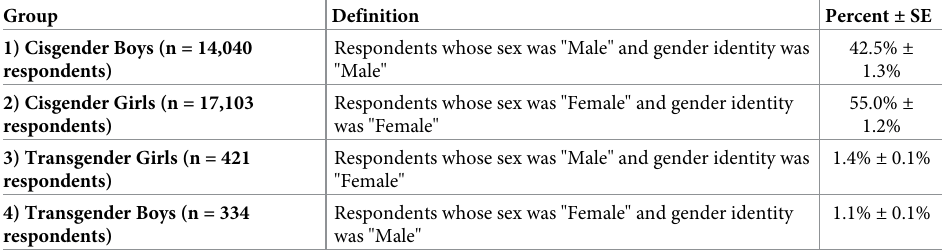
Table 1. Gender classification definitions of respondents and proportions, weighted percent ± standard error (SE) (n = 31,898 respondents).